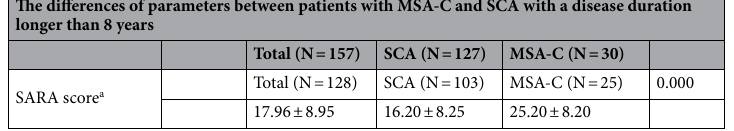
Table 3. The differences of parameters between patients of MSA-C and SCA with different disease durations. a Mann-Whitney test. b Chi-square test. Numeric data are presented as mean ± standard deviation. HCBS hot cross bun sign; MSA-C multiple system atrophy, cerebellar type; SCA spinocerebellar ataxia; SARA Scale for the Assessment and Rating of Ataxia; NAA N -acetyl aspartate; Cr creatinine; Cho